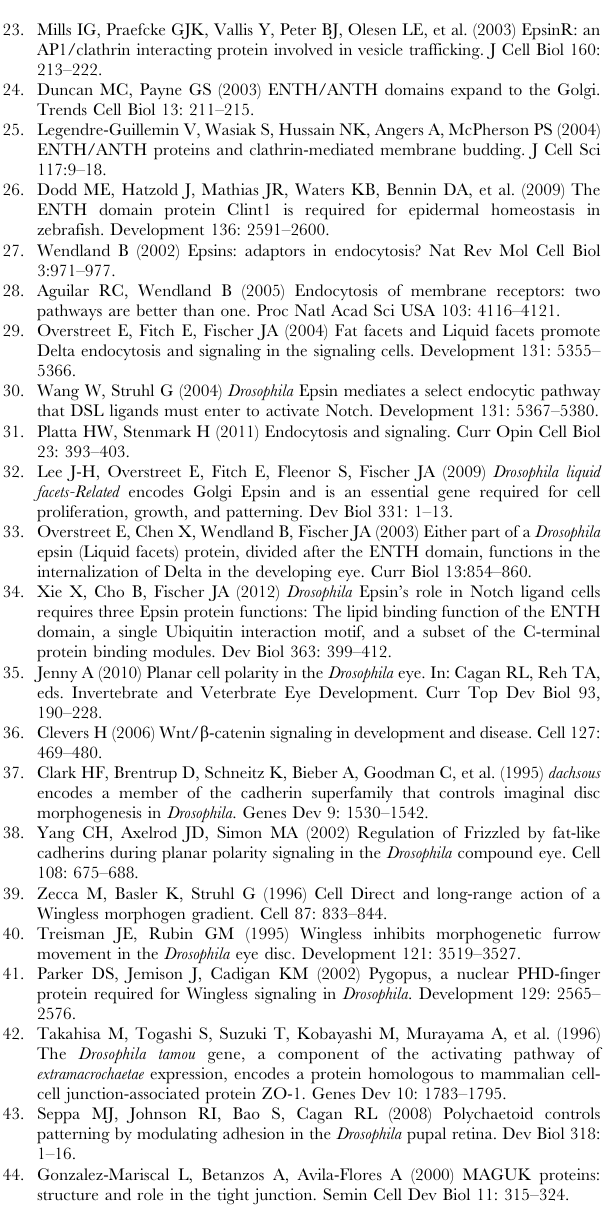
Figure S2 Rescue of E-cadherin accumulation abnor- mality in lqfR - clones by transgene expression. Confocal microscope images of three third instar larval eye discs immunostained with antibodies to E-cadherin (red). lqfR - clones are marked by the absence of GFP (green). The images at bottom are identical to the ones at the top except only the red layer is shown and the clone is outlined. (A–C 9 ) The discs express the transgenes indicated. The genotype is ey-flp; FRT82B lqfR D 117